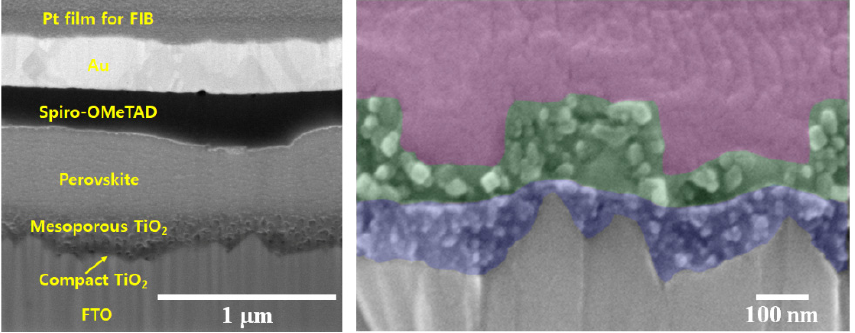
Figure 5. Cross-sectional images of perovskite solar cells using focused ion beam (FIB) and FE-SEM image with color-enhanced layer boundaries.